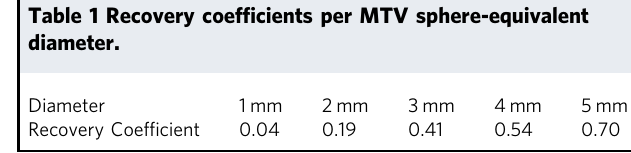
Table 1 Recovery coef fi cients per MTV